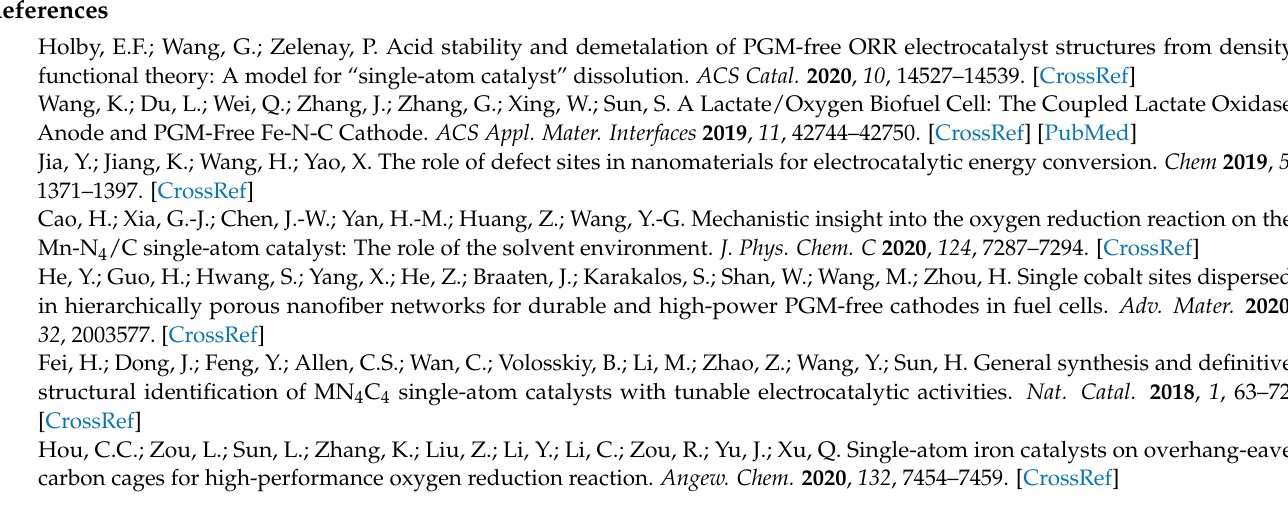
FeNP-NC/CNTs. Table S1: Fitting results of Fe foil EXAFS; Table S2: Fitting results of sample–Fe EXAFS; Table S3: Comparison of ORR performance with some reported non-precious catalysts